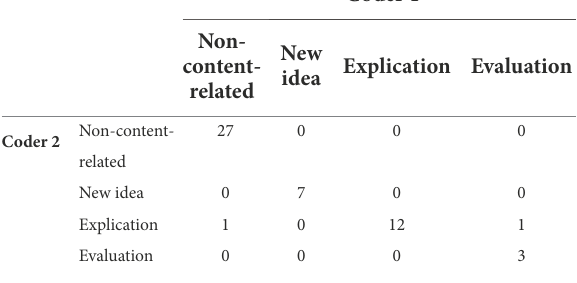
TABLE 1 The contingency table shows the agreements and disagreements in the coding of the conversations between two